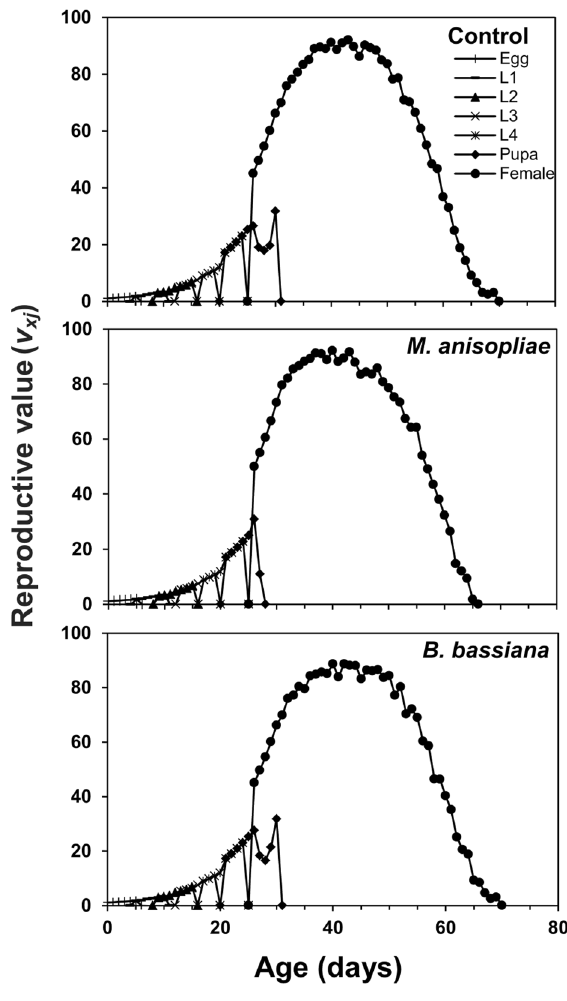
Figure 3. Age-stage–specific reproductive rate ( v xj ) of Coccinella septumpunctata after exposure of entomopathogenic